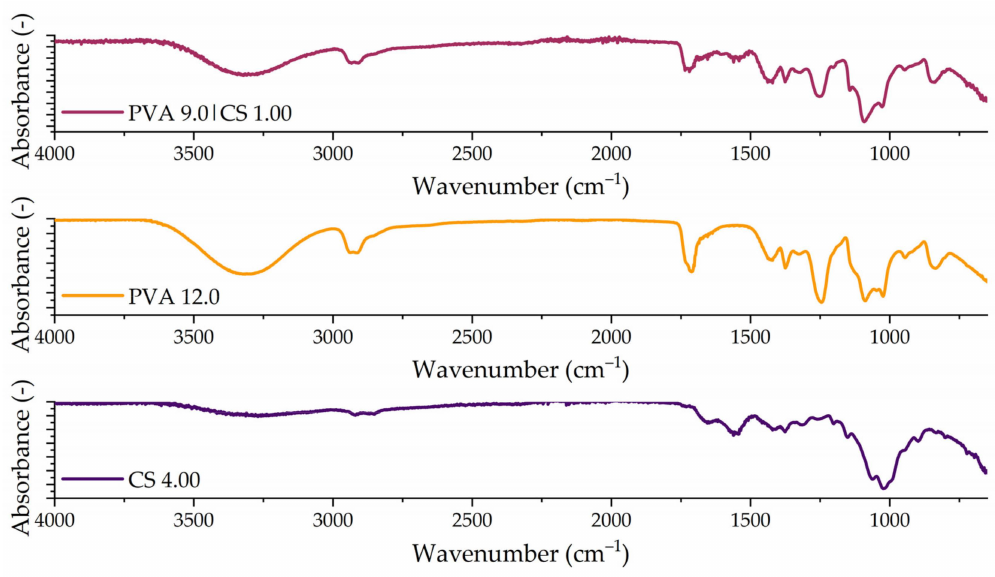
Figure 2. FTIR spectra of the pure samples (PVA 12.0 and CS 4.00) and after the blend at the PVACS ratio of 75:25 (PVA 9.0|CS